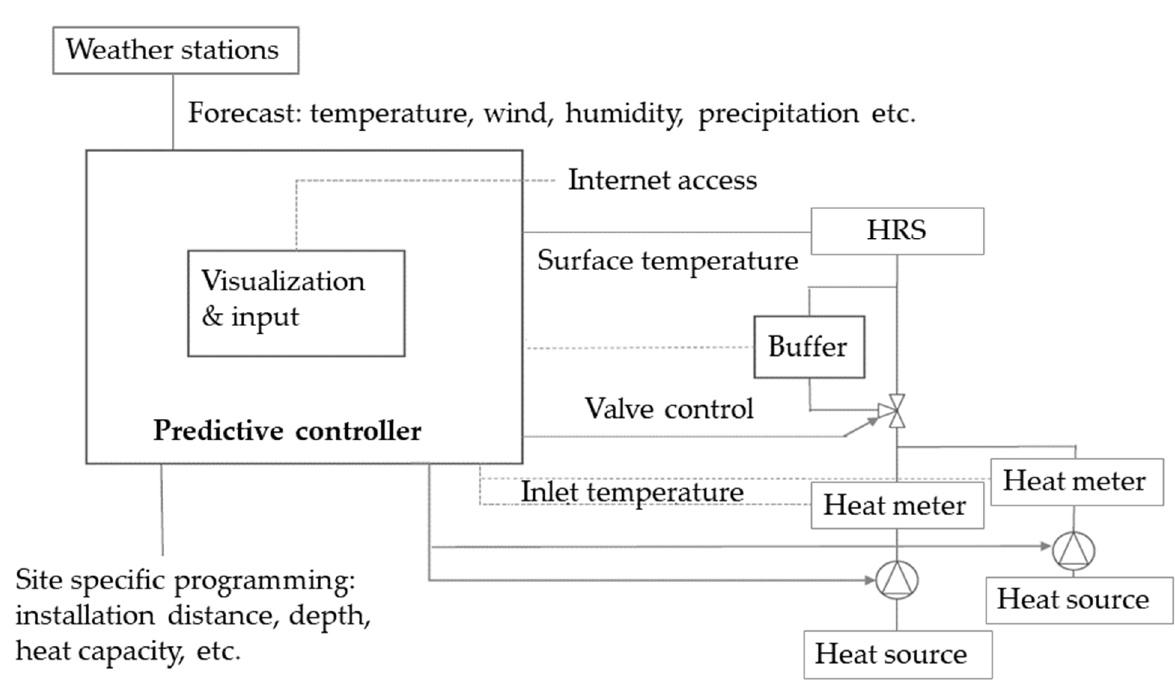
Figure 13. Schematic layout of a predictive controller for hydronic road-heating systems.